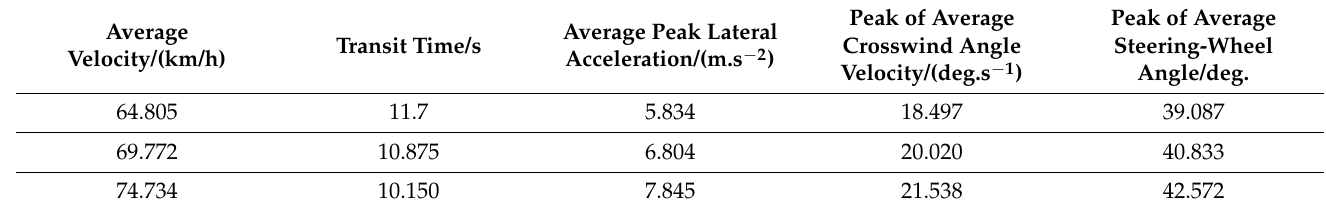
Table 9. Performance index scores of 65, 70 and 75 km/h serpentine tests without